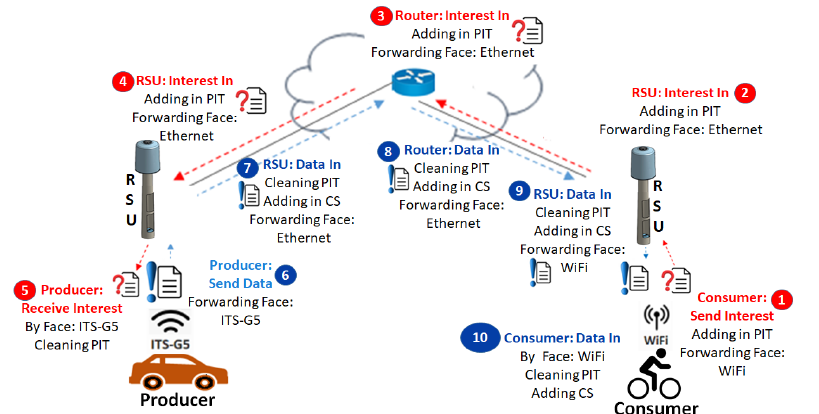
Figure 6. Messages exchanged following the NDN architecture and heterogeneous radio access